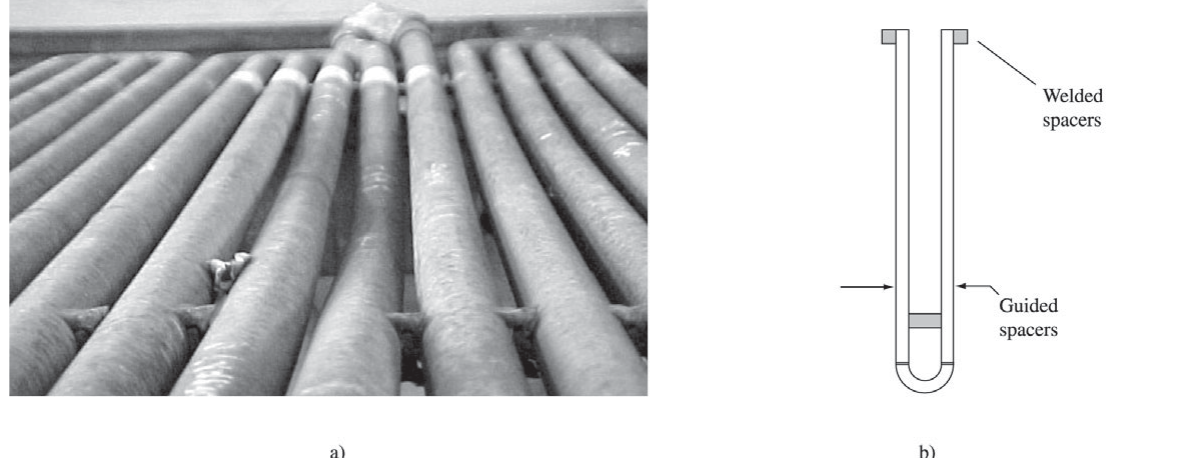
Figure 5. a) The assembly studied, showing the residual plastic deformation in the outlet tube, with a lateral deflection of 57 mm; b) Model for calculation of deformations with ANSYS